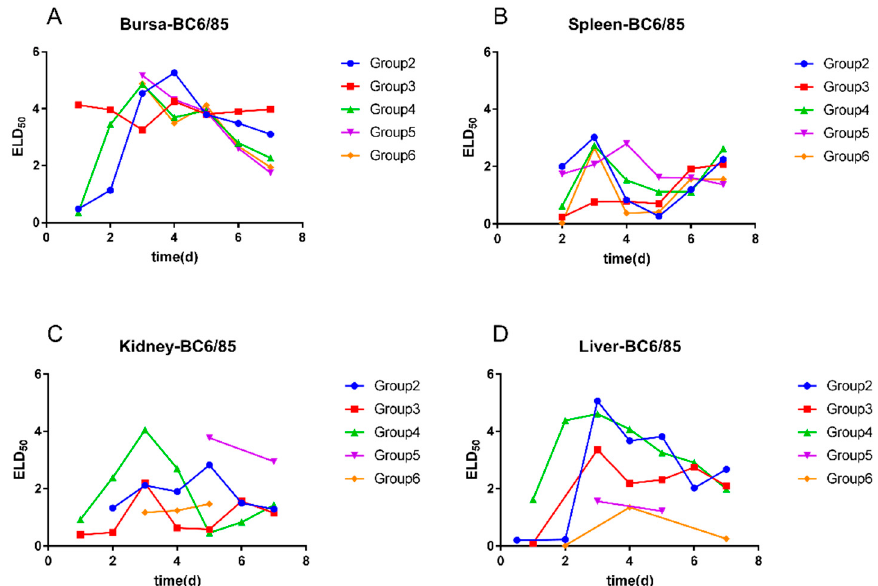
Figure 4. Viral loads of BC6/85 in the bursa of Fabricius, spleen, kidney, and liver of SPF chickens in different groups. ( A ) BC6/85 in the bursa of Fabricius, ( B ) BC6/85 in spleen, ( C ) BC6/85 in kidney, and ( D ) BC6/85 in liver.